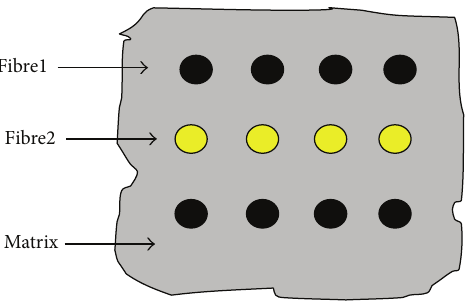
Figure 1: Concept of square unit cell for aligned pattern of hybrid composite with two different types of fibres.